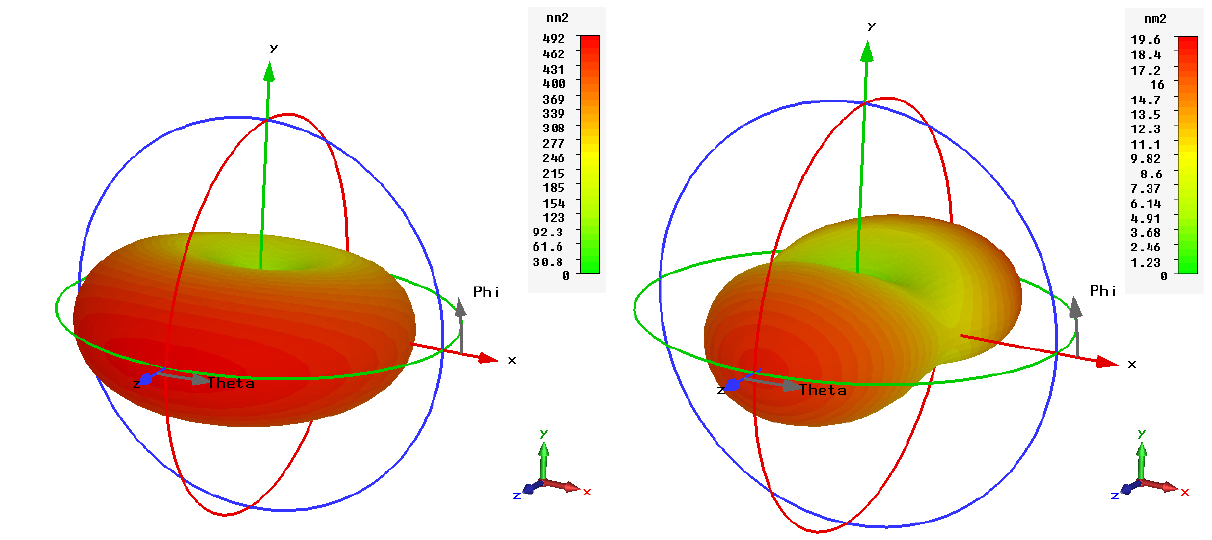
Figure 9. 3D scattering cross section (SCS) of the second cylinder both in the uncloaked ( left ) and cloaked case ( right ). Please note the different plot